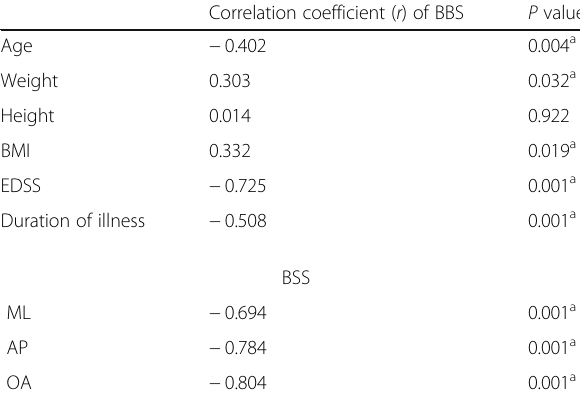
Table 5 Correlations between BBS and the patients ’ data Correlation coefficient ( r ) of BBS